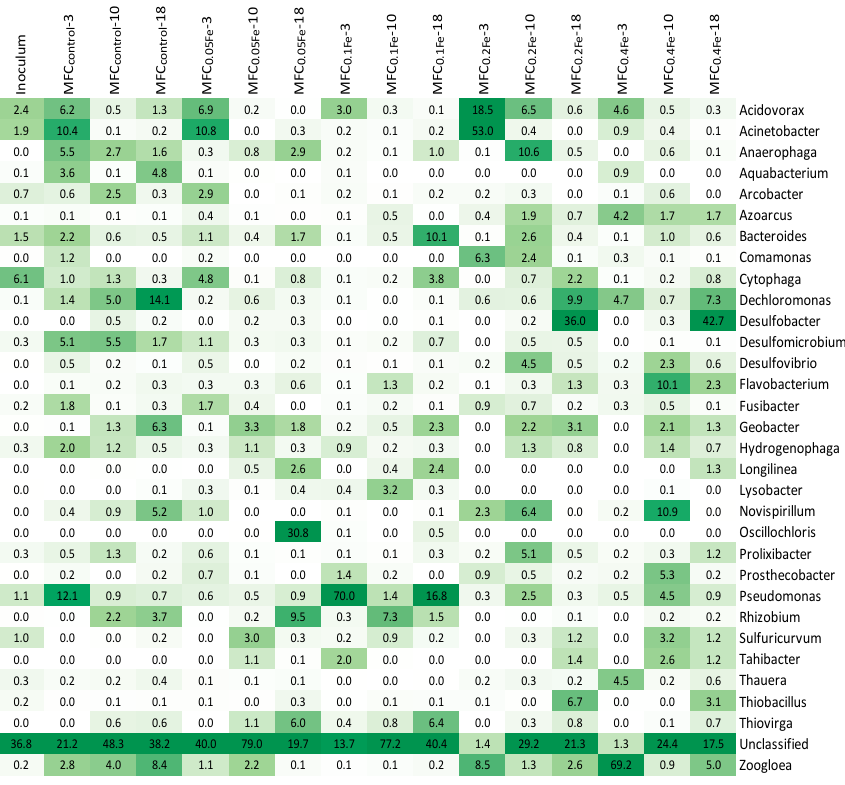
Figure 7. Heatmap showing 30 of the most numerous genera in the investigated MFCs, the number after the reactor name indicates the cycle in which sampling was performed.